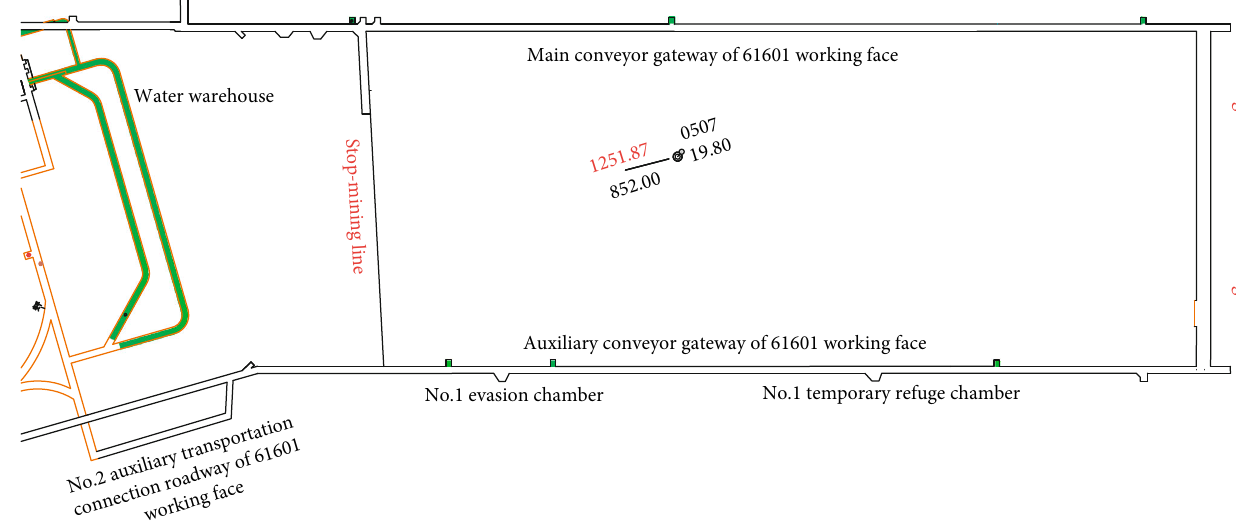
Figure 1: Plan view of the 61601 working